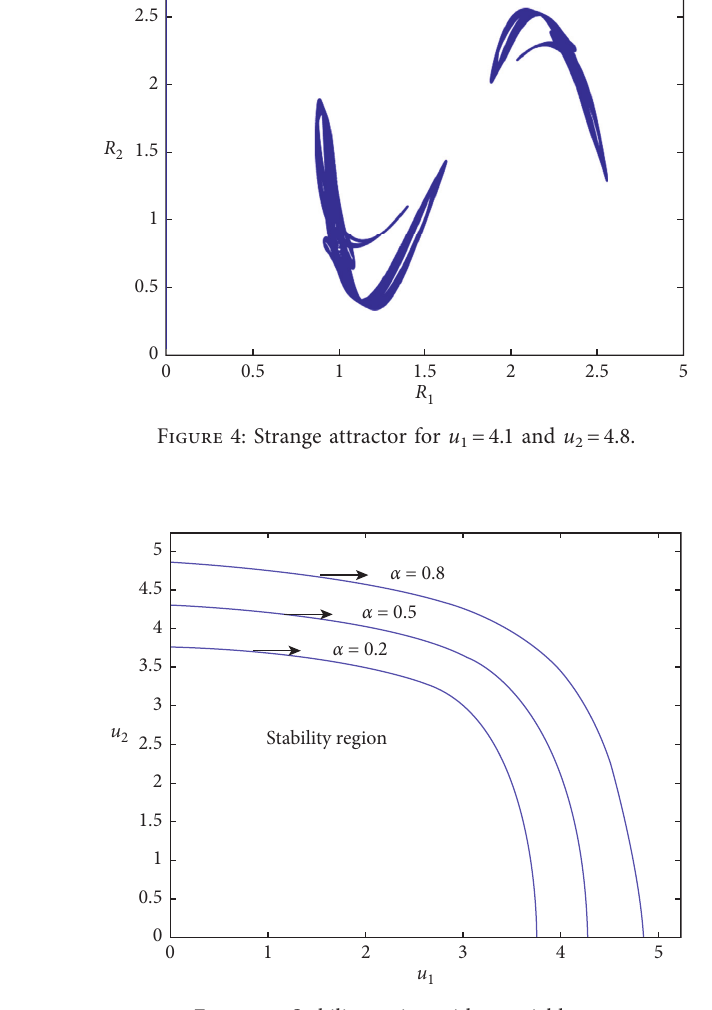
Figure 5: Stability region with a variable α .